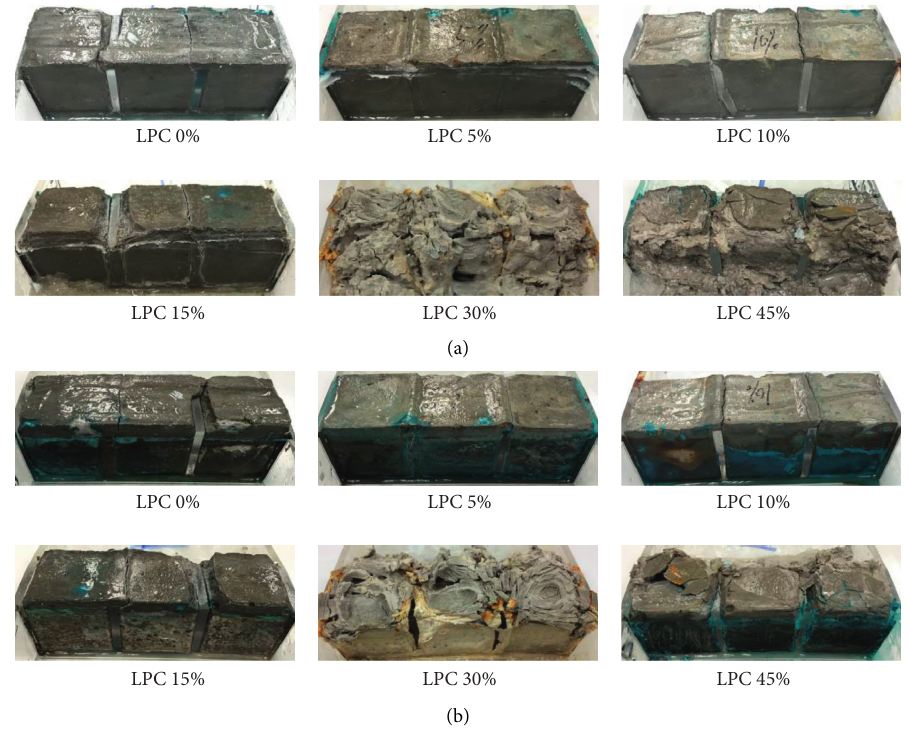
Figure 4: Appearance of different limestone powder contents at 120 days (LPC: limestone powder content). (a) Cathode surface and (b) anode surface.